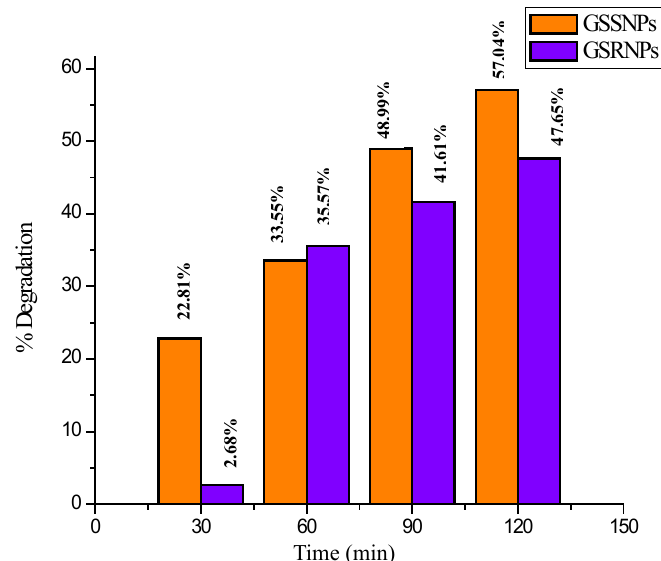
Fig. 8: % Degradation of Methyl orange dye using GS-SAgNPs and